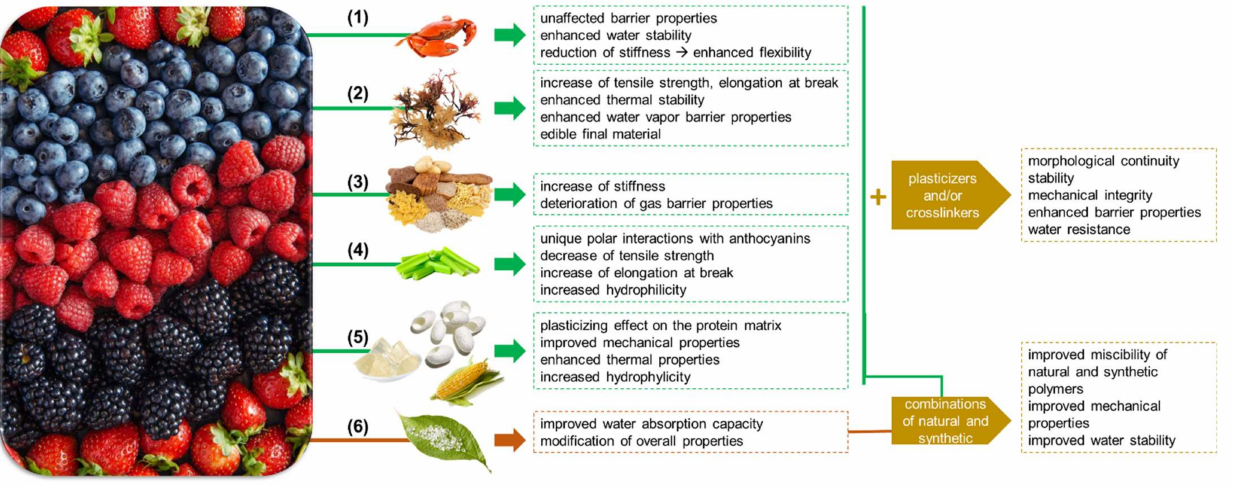
Figure 3. Types of anthocyanin polymer composites and their properties. Anthocyanins combined with a. natural polymers: (1) chitosan, (2) carrageenan, (3) starch, (4) cellulose, (5) proteins, or b. with synthetic polymers (6), as well as with combinations of natural with synthetic polymers and with plasticizers and/or crosslinkers. Image of berries representing anthocyanin sources reproduced from Encyclopædia Britannica, search query “anthocyanins”, https://www.britannica.com/science/ anthocyanin#/media/1/27352/252532 (accessed on 22 September